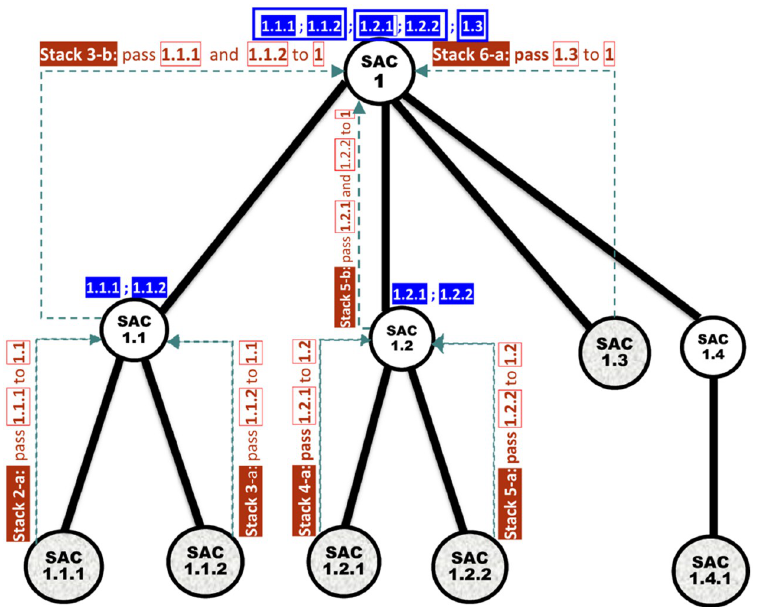
Fig 18. The MKCSS Relationship Tree in Fig 14-a after being annotated with the processing steps of Algorithm RELPlookup (Fig 13) that created the states of the stacks in Fig 14-b. The arrows and texts marked in brown colour describe the processing steps that created the stack states. The sets of nodes on top of SAC 1 are the two results produced by the algorithm: {1.1.1, 1.1.2, 1.3} and {1.2.1, 1.2.2, 1.3}.